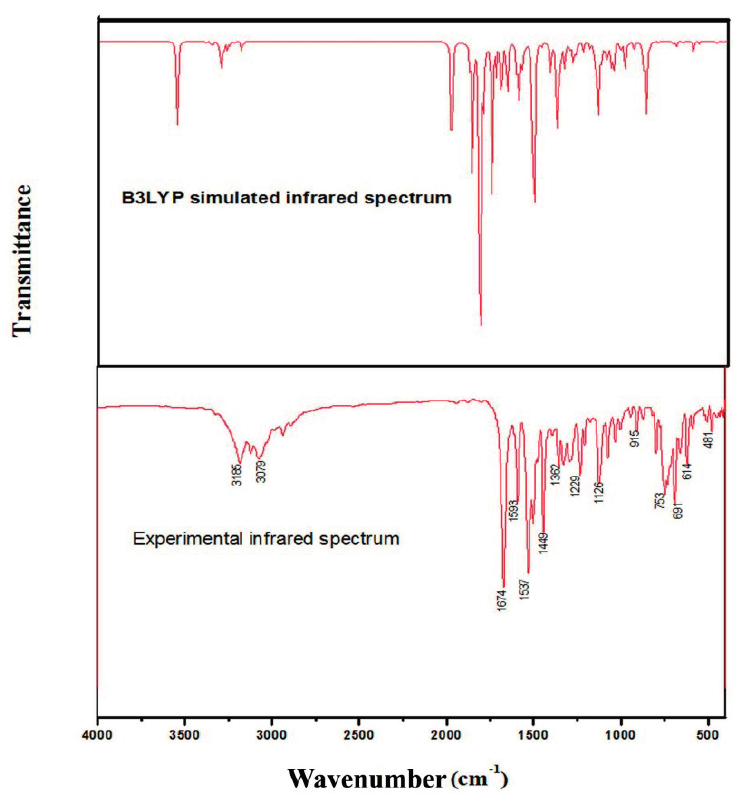
Figure 7. Theoretical (B3LYP) and experimental infrared spectra of (2 E )-HIPC.